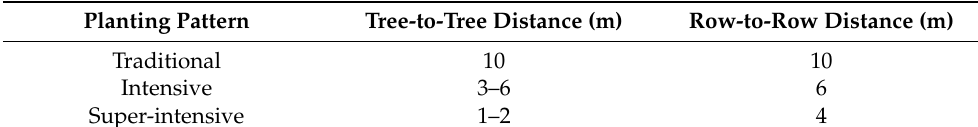
Table 3. Definition of subcategories for olive plantations based on tree-to-tree and row-to-row dis- tances measured on VHR Google Earth Imagery.